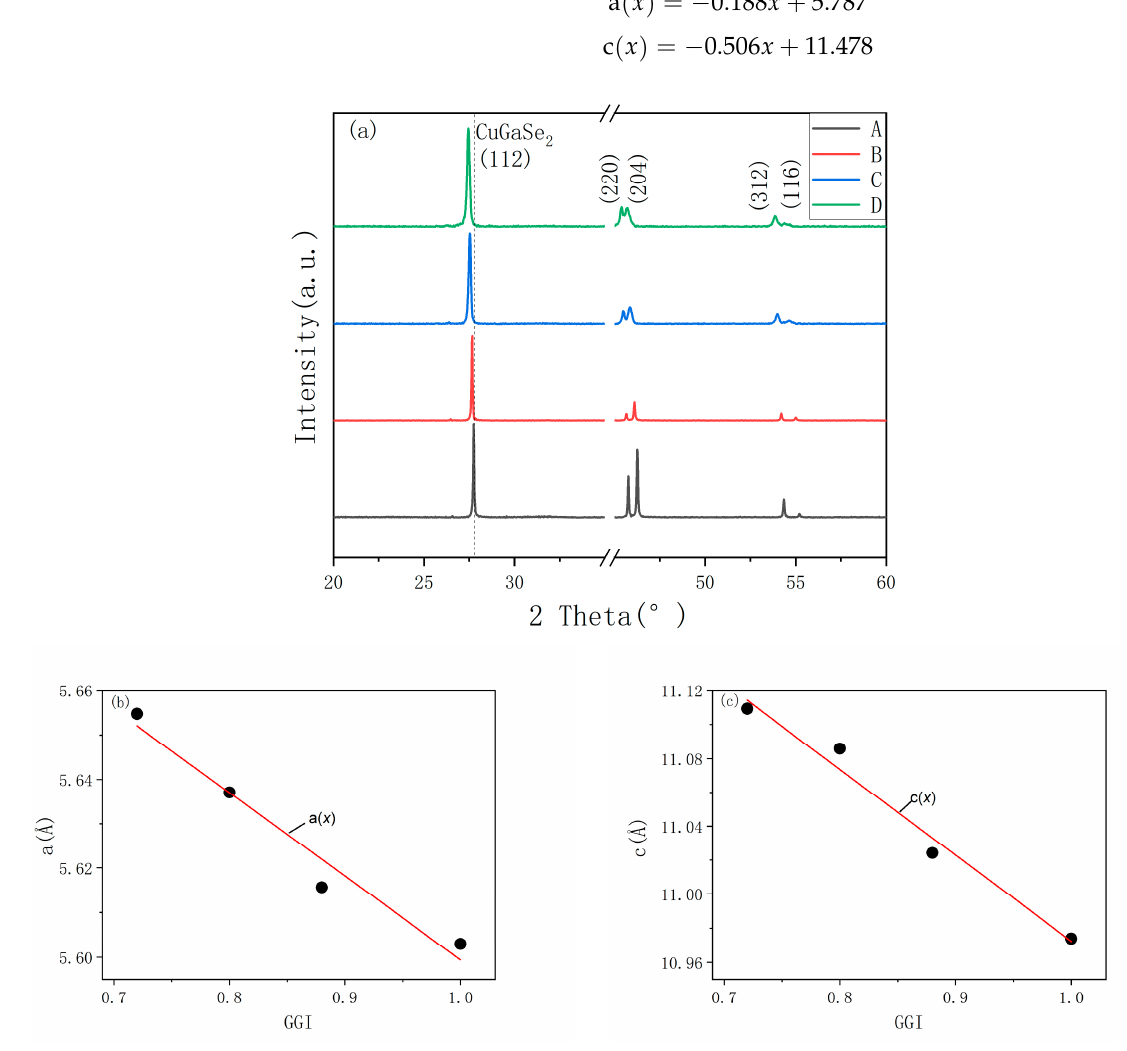
Figure 3. ( a ) The XRD spectra of the CIGS films with different gallium content, ( b , c ) lattice constants of a and c calculated from ( a ).